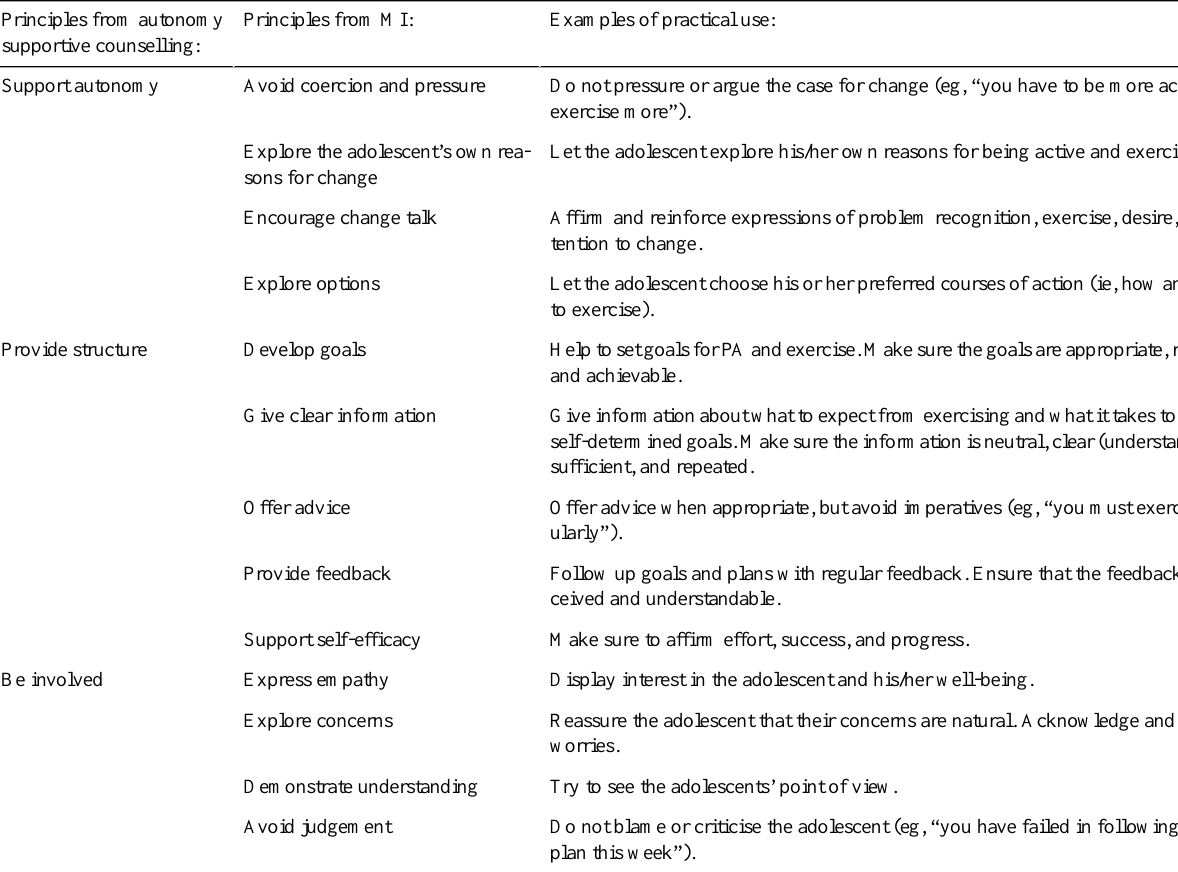
Examples of practical use:Principles from MI:Principles from autonomy